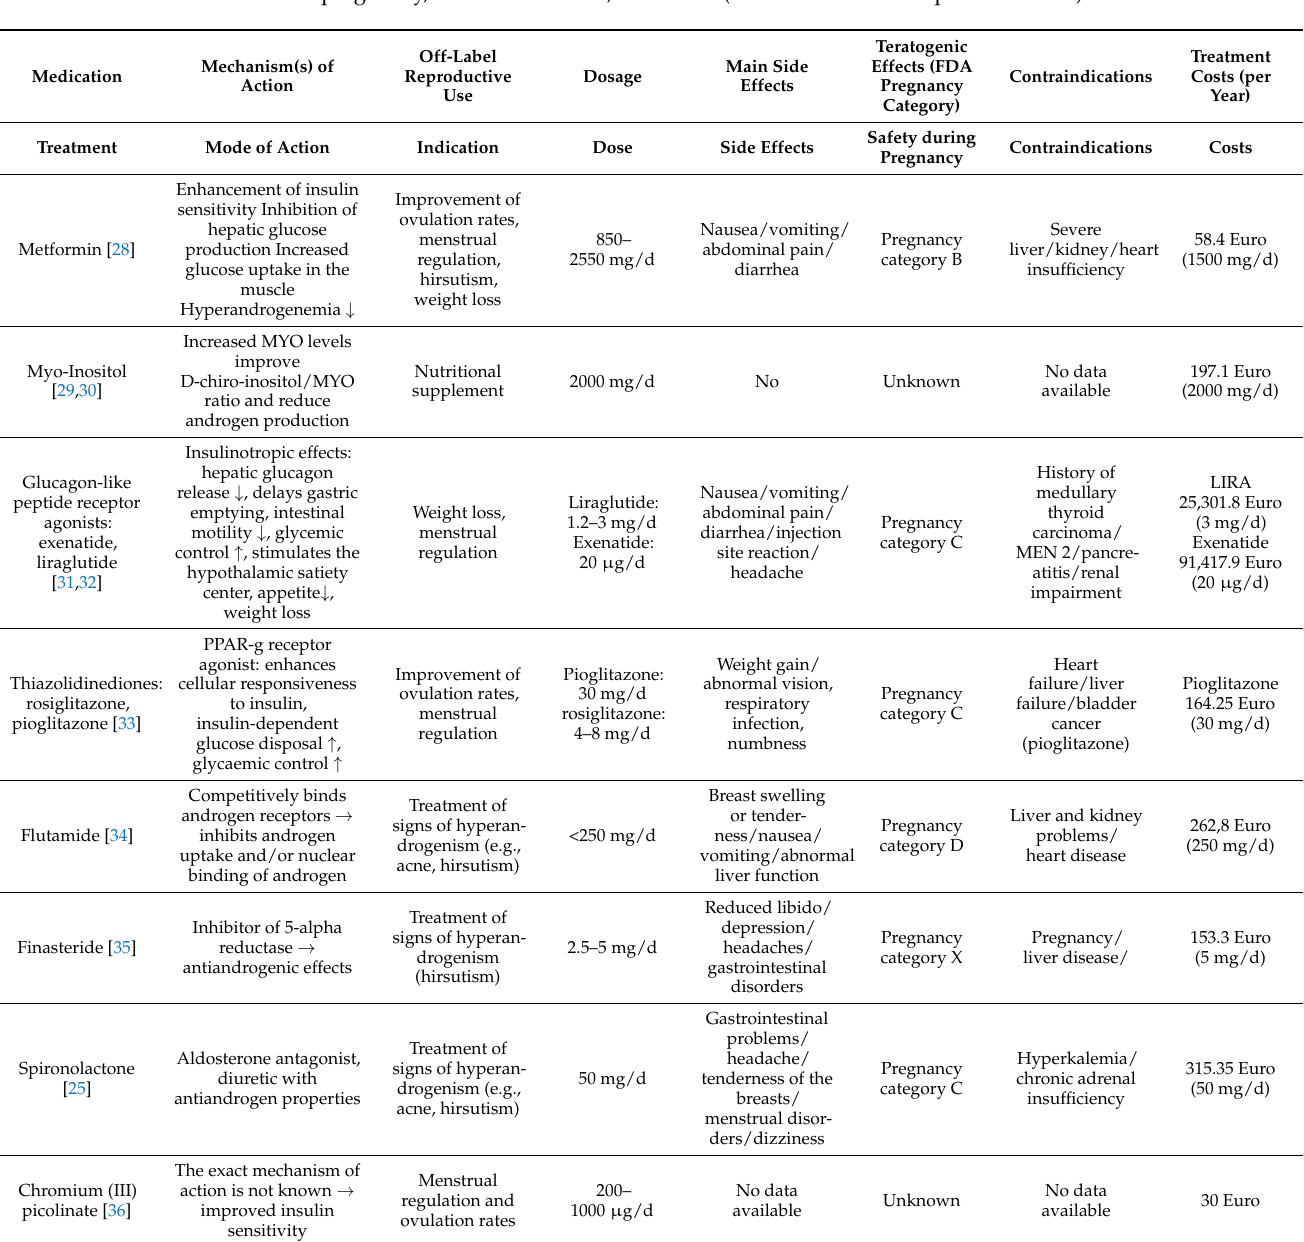
Table 2. Overview of treatment options, mode of action, indication, dose, side effects, safety during pregnancy, contraindications, and costs. (Abbreviations are explained